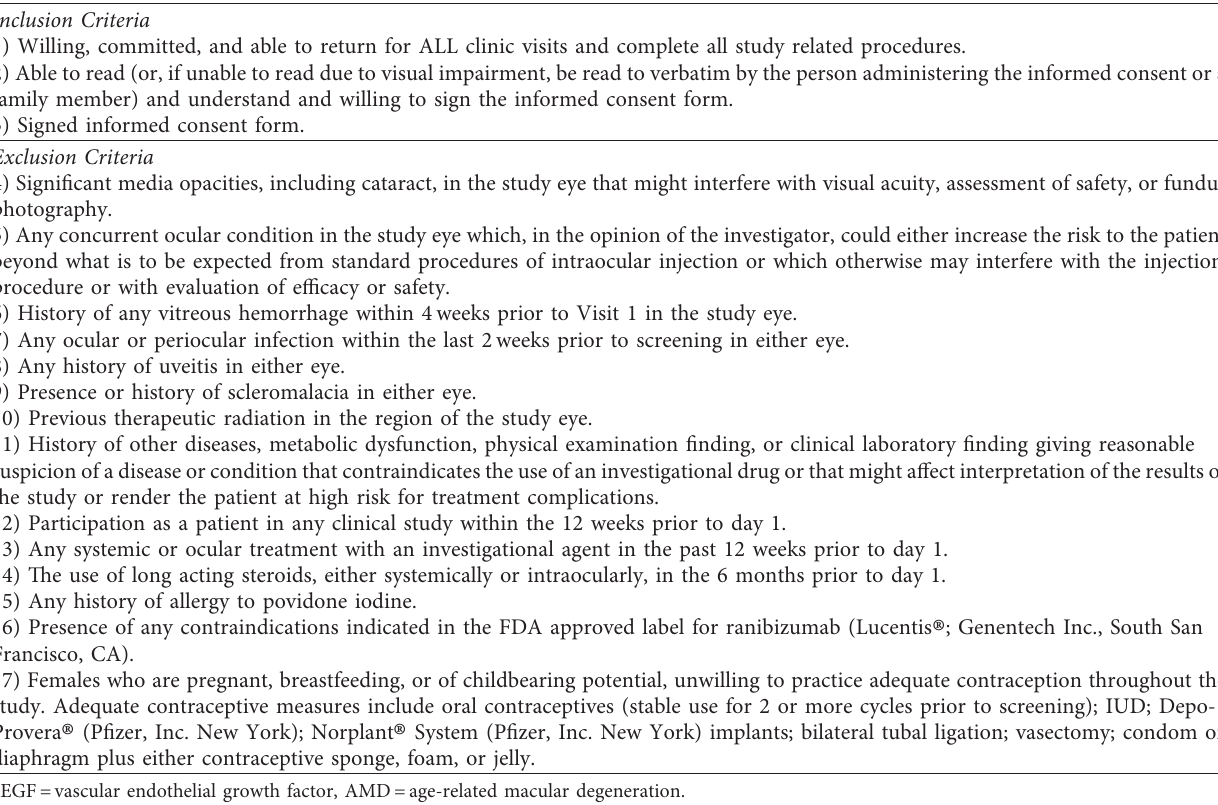
Table 2: Eligibility criteria of the VEGF Trap-Eye: Investigation of Efficacy and Safety in Wet AMD studies required for inclusion in the present study (category 2).